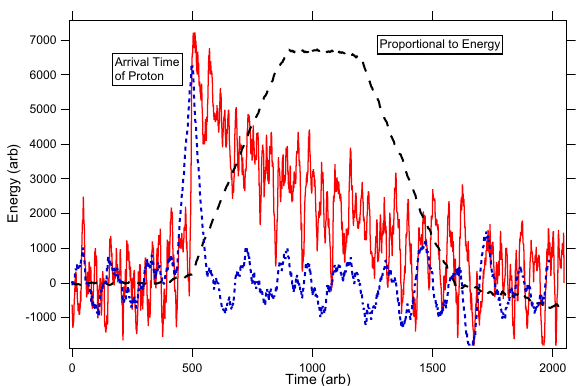
Figure 3. Example 1-dimensional timing (a) and energy (b) histograms and a 2-dimensional histogram showing the counts versus timing and energy (c).